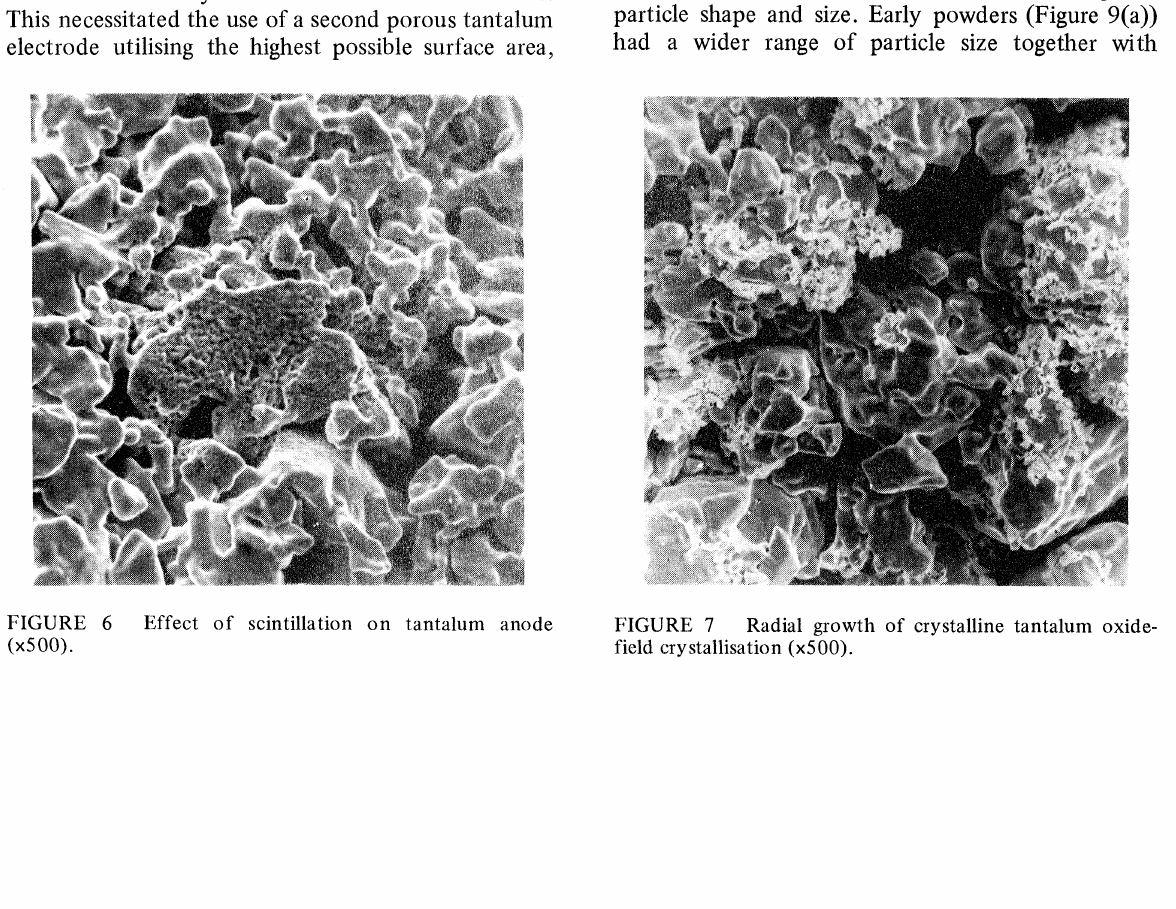
Effect of scintillation on tantalum anode (xS00).